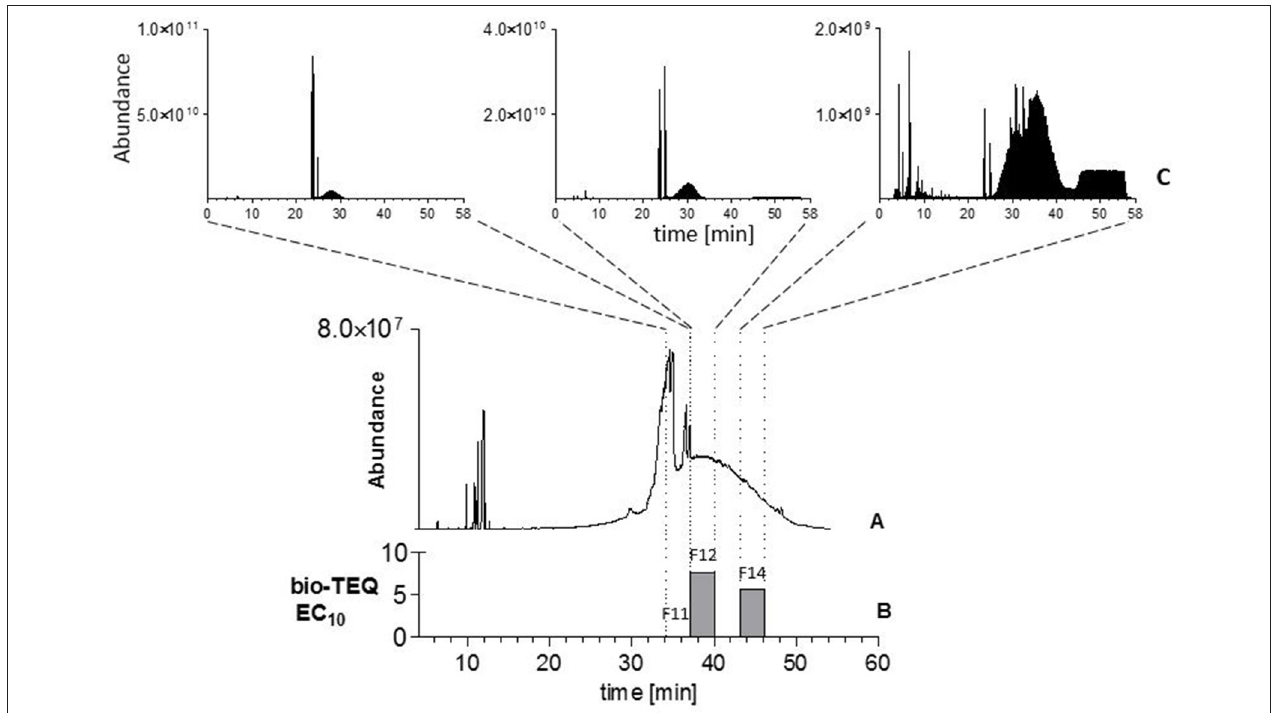
FIGURE 3 | Effect-directed analysis conducted in pooled plastic pellets of marine deployed HIPS. (A) GC- MS chromatogram of the pooled HIPS sample. (B) Measured bio-TEQs in pg/g (EC 10 ) of 17 fractions of pooled HIPS. Dashed lines represent fractions 11, 12, and 14, which induced AhR-mediated potencies in the DR